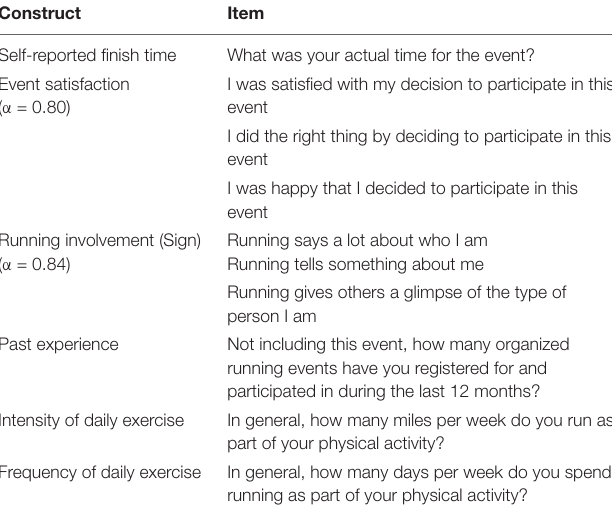
TABLE 2 | Post-event survey measurement